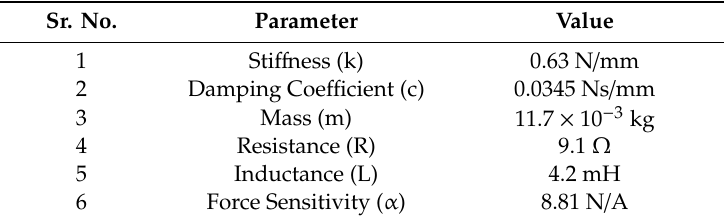
Table 1. Properties of the mechanical and electrical system.